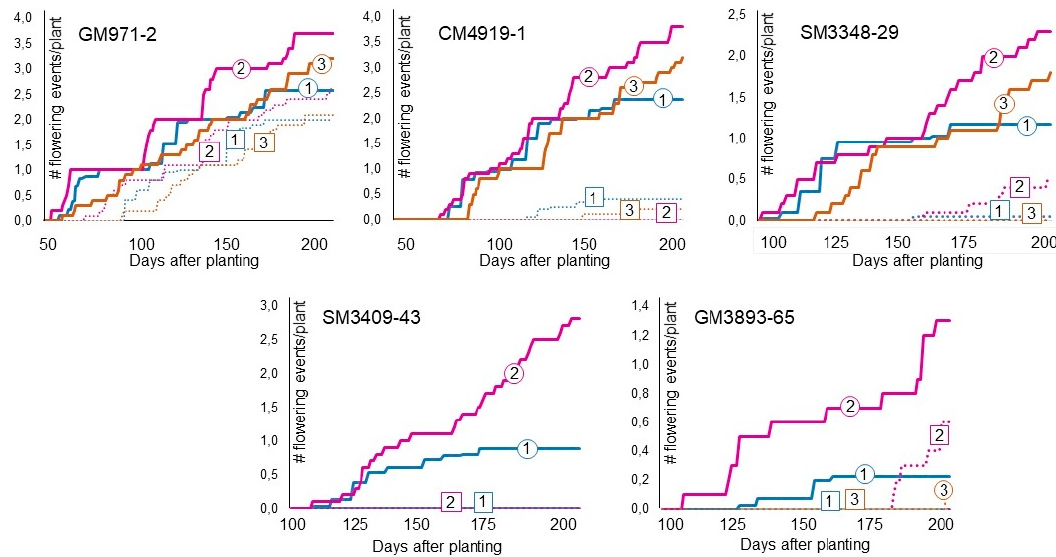
Figure 4. Average number of branching (e.g., flowering) events per plant in five genotypes evaluated in three consecutive harvesting seasons (except for genotype SM 3409-43). The horizontal axis presents the days after planting. Colors and numbers identify experiments and seasons: (1) Experiment 1 in 2016/17; (2) Experiment 1 in 2017/18; and (3) Experiment 2 in 2018/19. Numbers in circle and solid lines identify responses under extended photoperiod (averages of the four different light treatments for Experiment 1 in 2016/17). Numbers inside squares and doted lines identify the progress of flowering in the check plots under normal (dark) night conditions. Table 3. Summary of relevant results from Experiments 1 and 2. Top : linear regression coefficients of the average number of flowering events. Within parenthesis are the respective standard errors for the coefficients. Middle : Average number of flowering events per plant 200 DAP. Bottom : average number of days to the second branching event. Within parenthesis, is the percentage of plants that flowered twice (or more) a .